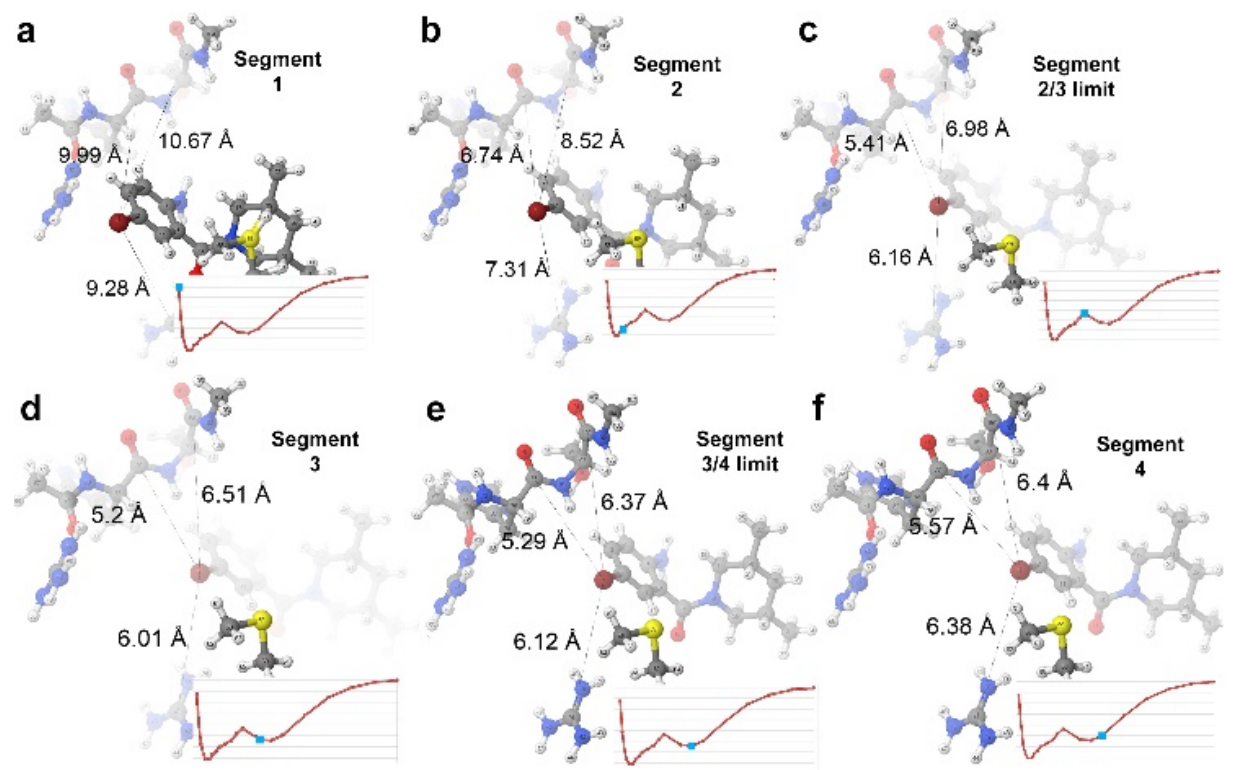
Figure 6. Representation of the charges in the allosteric site as the 3CJ2 ligand moves away (up- wards), showing how the bromine from the bromo-aryl moiety affects the energy landscape. As the ligand moves away from the pocket, the bromine interacts with the positive charges in the outer part of the pocket, leading to a small segment where the system’s energy becomes more negative as the ligand moves away, which explains segment 3.